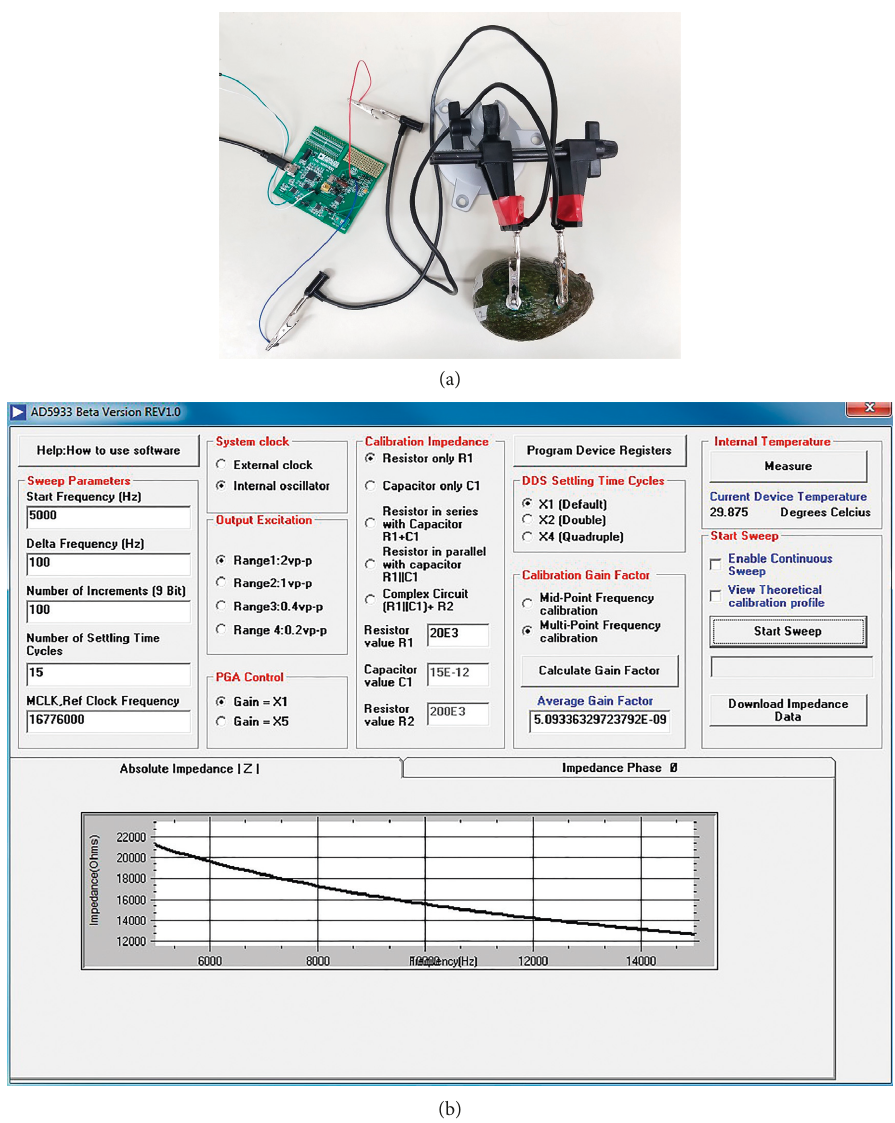
Figure 1: Hardware and software utilized for data acquisition: (a) AD5933 evaluation board and (b) snapshot of the supporting software’s graphic user interface.